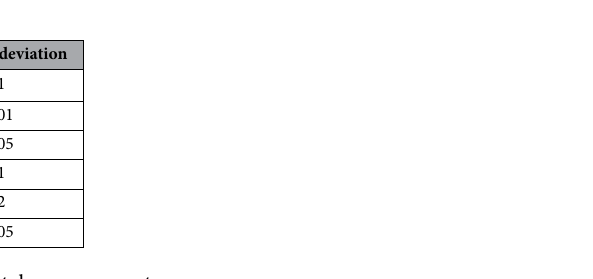
Table 6. Errors associated with experimental measurements.